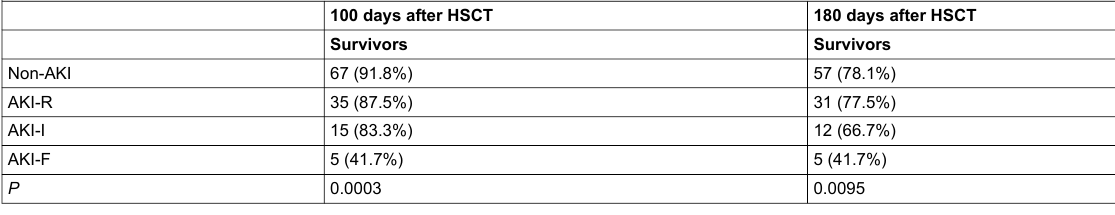
Table 5: Clinical outcomes stratified by RIFLE category.